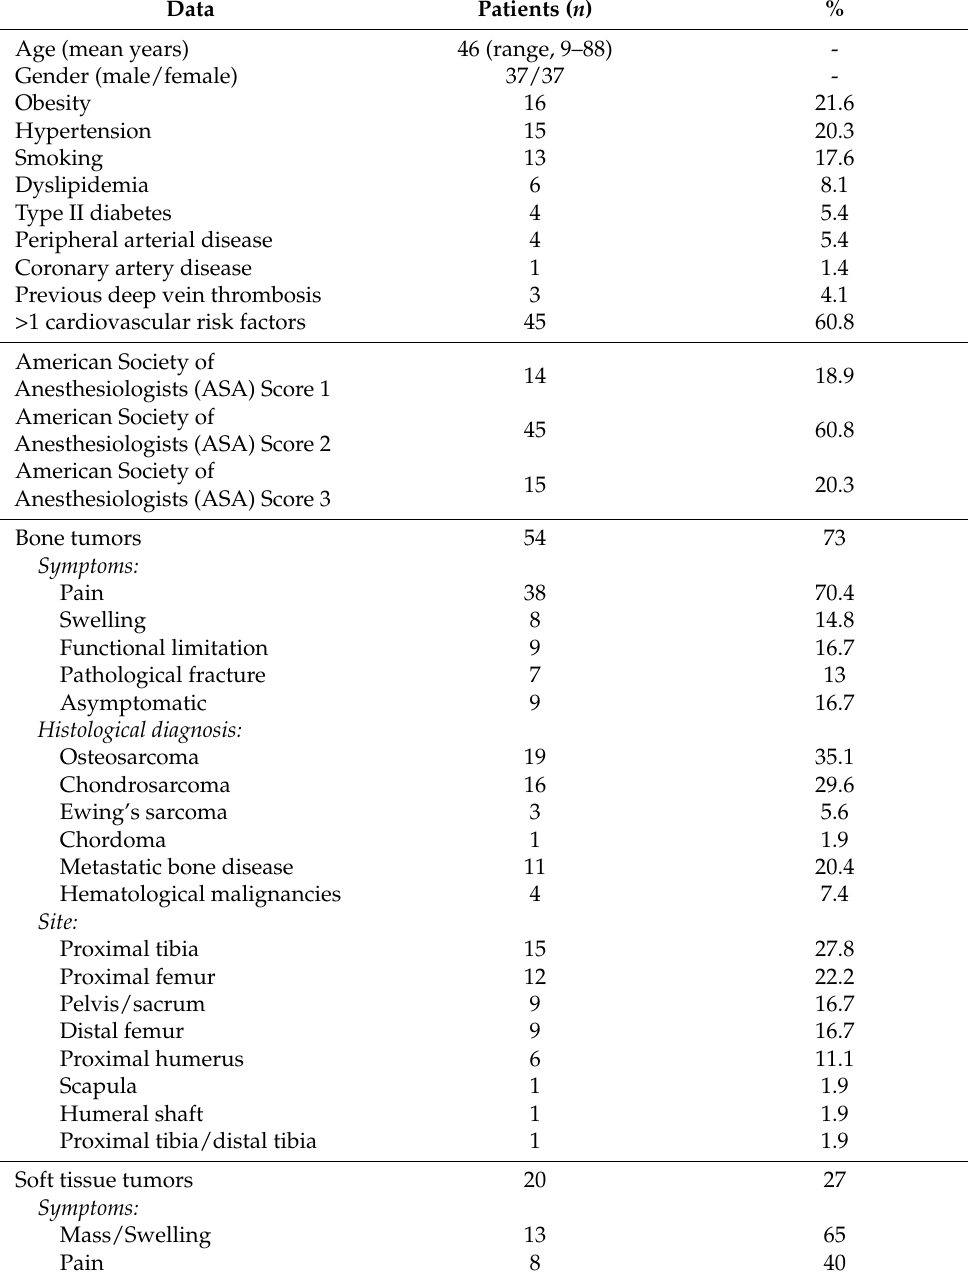
Table 1. Demographic details of the patients ( n = 74) included in this